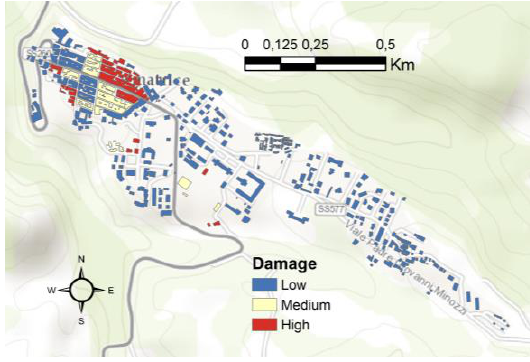
Figure 3 : Damage classification by using all change fea- tures (both optical and SAR) over Amatrice town The most affected area is the historical centre of the town and in particular the West side as visible in Fig. 4.